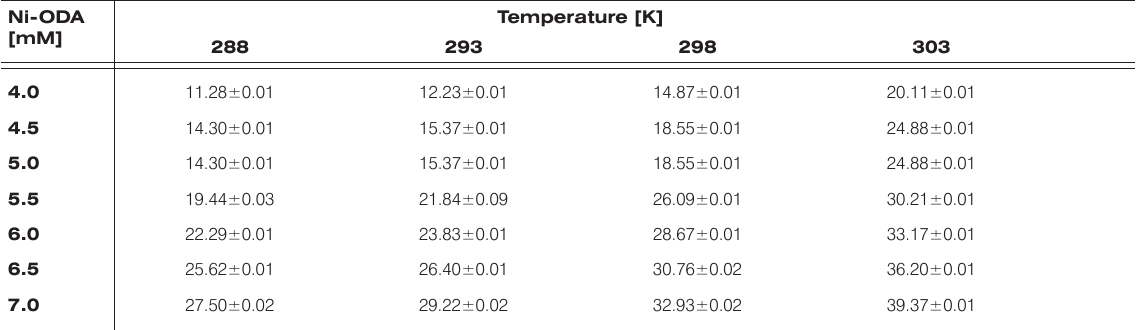
Table 3. Concentration and temperature dependences of rate constants k (s -1 ) (± standard derivation) of the substitution of Ni-ODA with bipy. The concentration of bipy is constant and is equal to 2.88 mM.